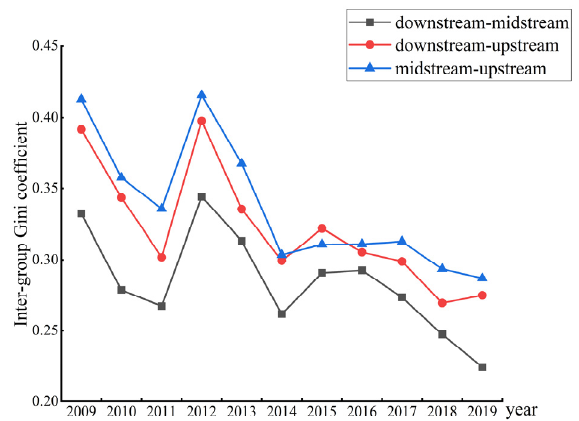
Figure 3. Regional differences of the EWP in YREB.